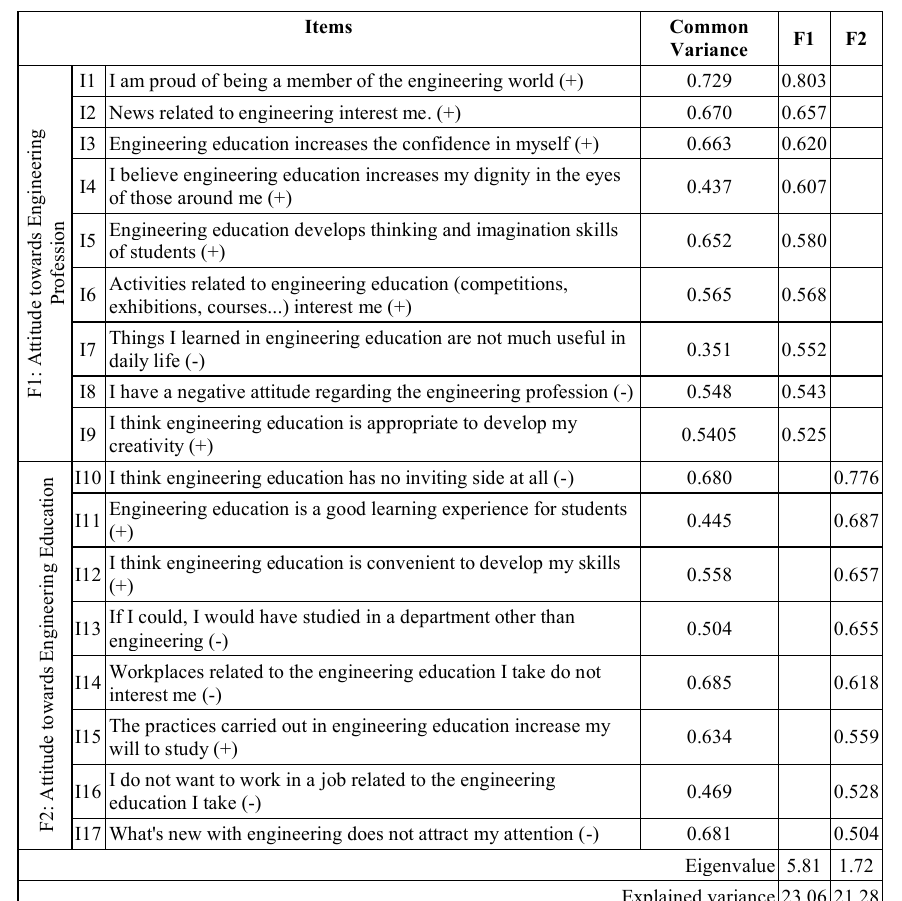
Table 2. Exploratory Factor Analysis